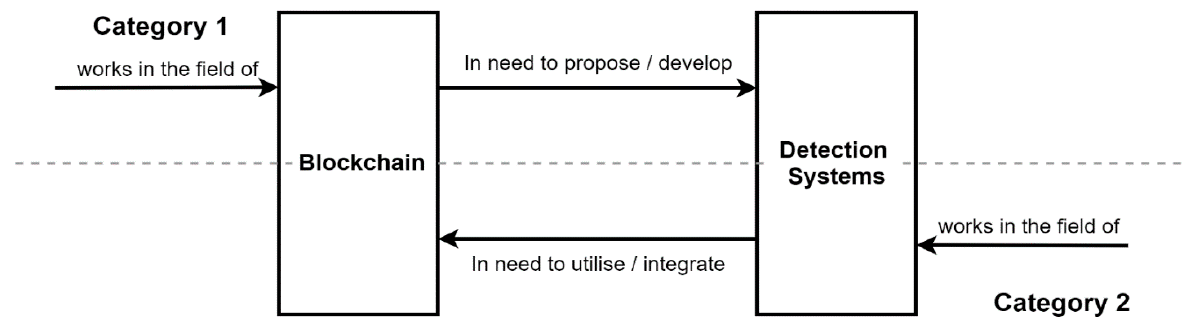
Figure 2. The relationship between blockchain and detection techniques